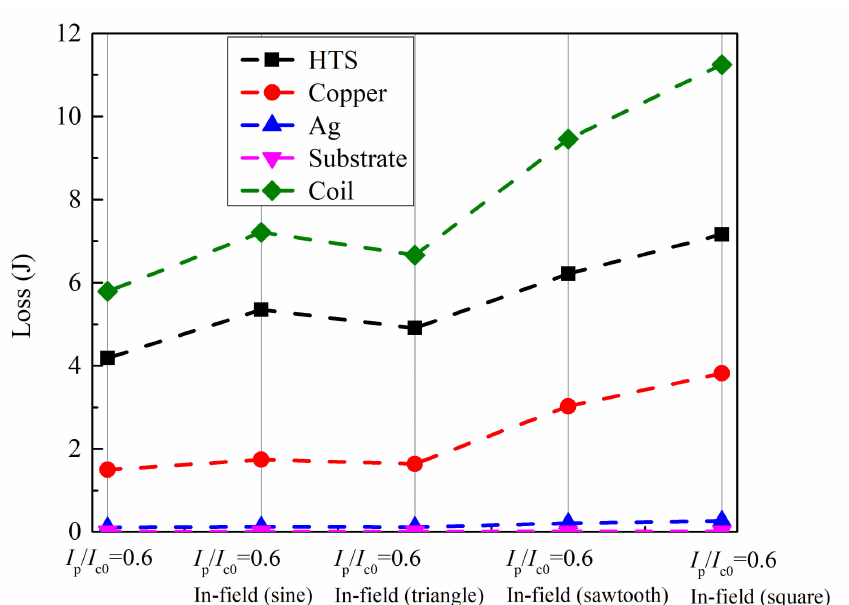
Figure 11. The loss distribution of different layers in the REBCO coil under self-field and different external oscillating magnetic fields when I p / I c0 = 0.6. (The external magnetic field magnitude is B p = 0.5 T).